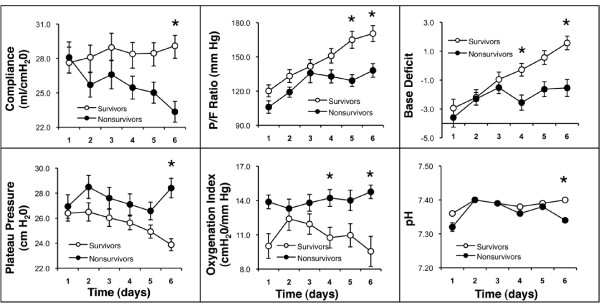
Trends in measures of oxygenation, respiratory compliance and acid base balance during the first 6 days of mechanical ventilation for acute lung injury. Data are shown as mean ± SEM. The * indicates p < 0.05.